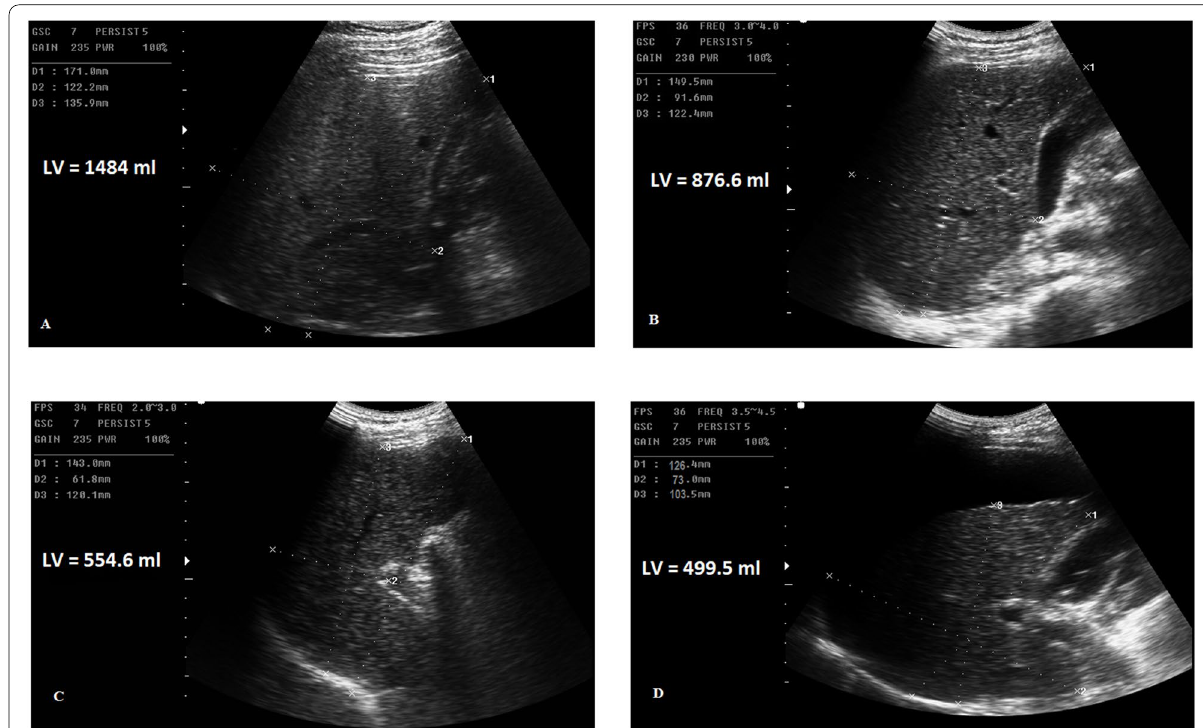
Fig. 2 Ultrasonographic calculation of the liver volume. A Liver volume in normal subject. B Liver volume in early cirrhotic patient. C Liver volume in cirrhotic patient with portal vein thrombosis treated with sorafenib. D Liver volume in shrunken liver complicated with ascites after